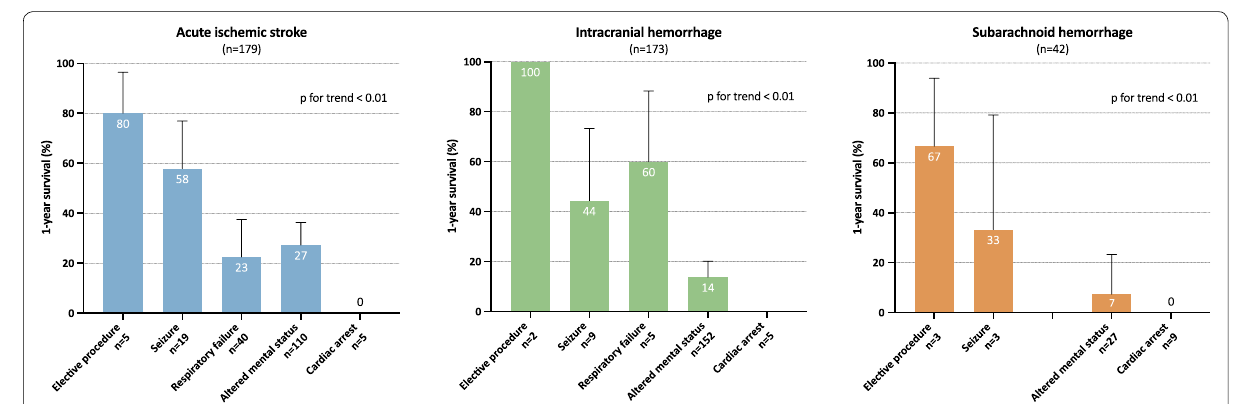
Fig. 2 Survival rates according to stroke type and reason for endotracheal